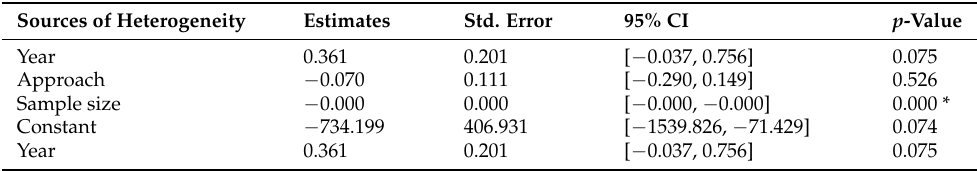
Table 5. Meta-regression model to assess the source of heterogeneity.